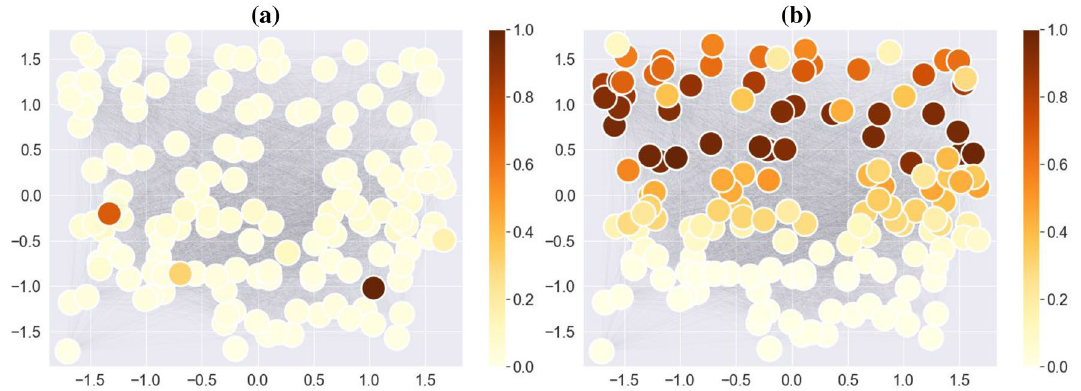
Figure 7. Fully-connected graphs for npos_2WellGraph dataset with nodes coloured based on the relevance scores of the LRP method that are summed across 2 states: ( a ) State 1 and ( b ) State 2. The locations of 2 states are obtained by clustering points of the graph embedding of the time-evolving graph via k -means.